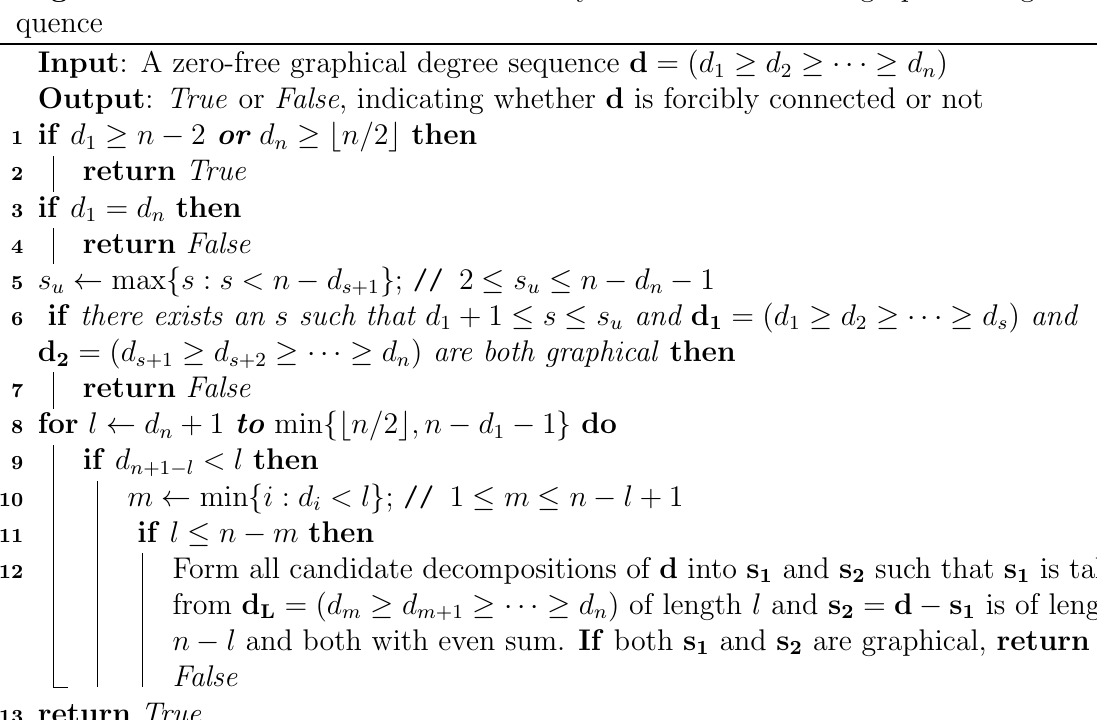
Algorithm 1: Pseudo-code to test forcibly-connectedness of a graphical degree se-